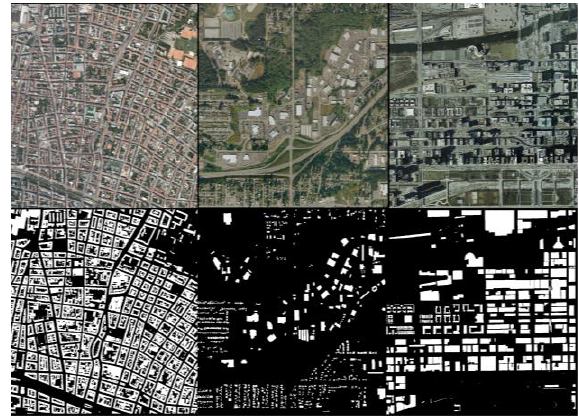
Figure 4. The images and their related masks from the Inria aerial image dataset belong to the Vienna, Kitsap, and Chicago regions. The images have a dimension of 5000 × 5000